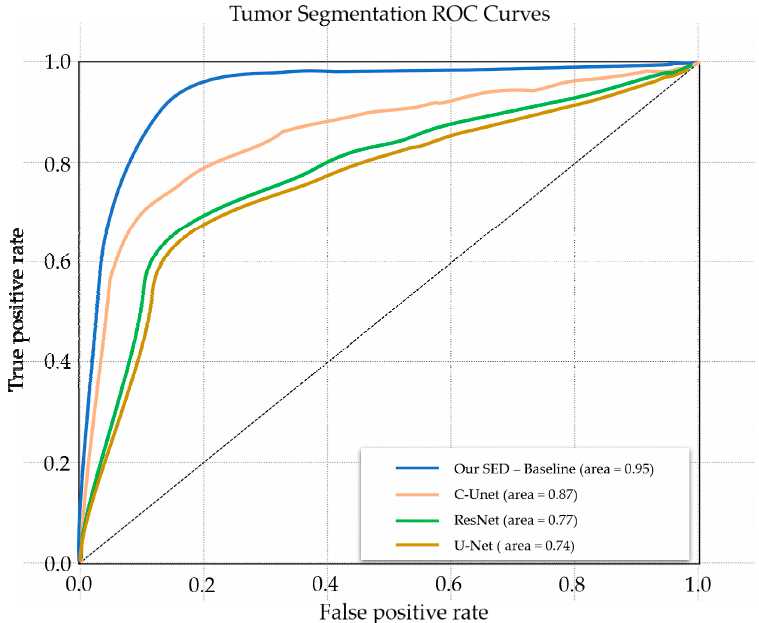
Figure 4. ROC curves of the state-of-art methods and the proposed SED method.